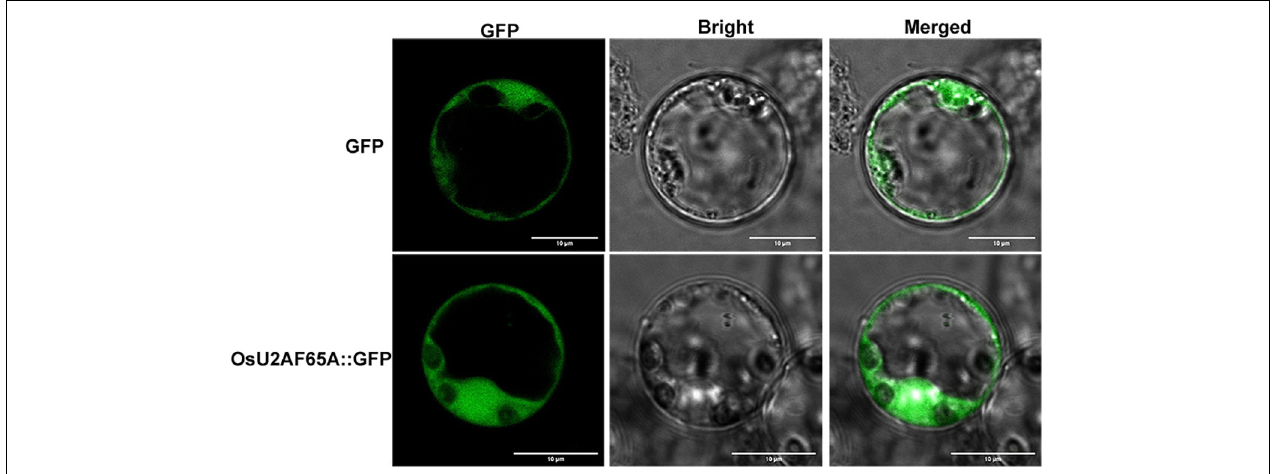
FIGURE 4 | Analysis of the subcellular localization of OsU2AF65A. OsU2AF65A is localized to the nucleus and cytoplasm. The plasmid containing OsU2AF65A -GFP or GFP was transformed into rice protoplasts. Examination was performed under a confocal laser scanning microscope in the dark field for green fluorescence (left) , white field (middle) for cell morphology and in combination (right) , respectively; bar = 10 µ m. Experiments were repeated three times with similar